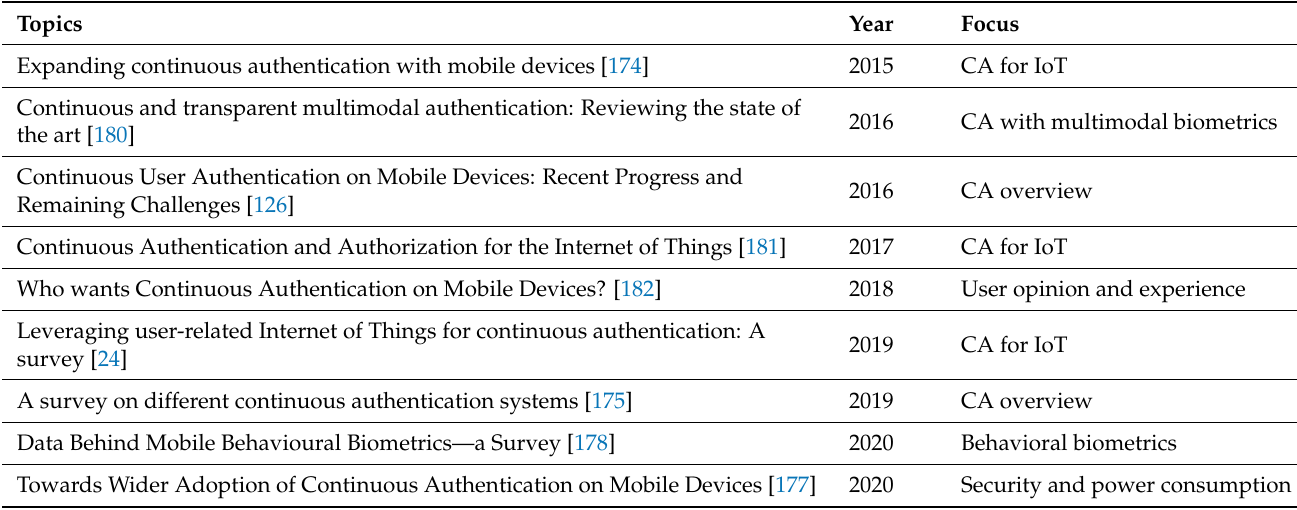
Table 10. A list of continuous authentication